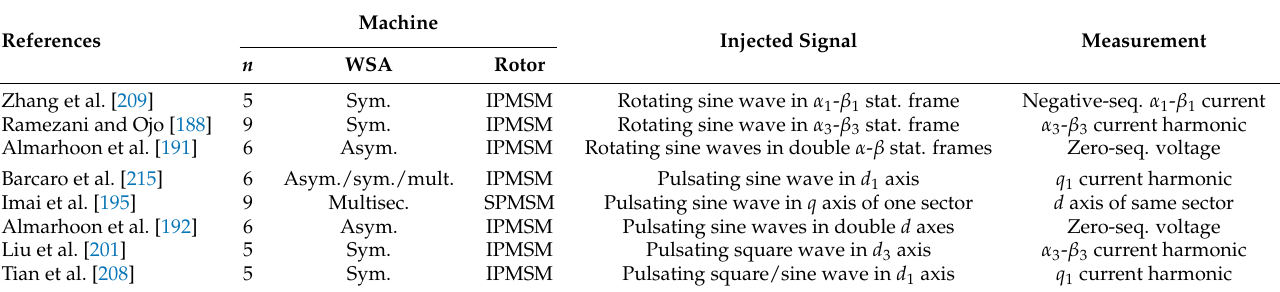
Table 19. Speed/position-sensorless methods based on high-frequency injection (Section 7.3.2.2) in multiphase applications in the